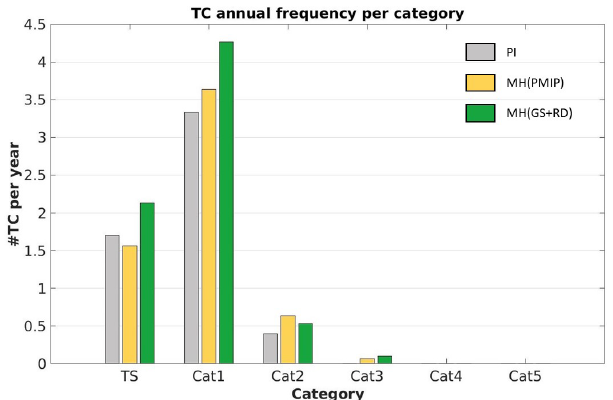
Figure 12. Climatological number of TCs per year in various cate- gories for the three experiment during the TC extended season (JJA-